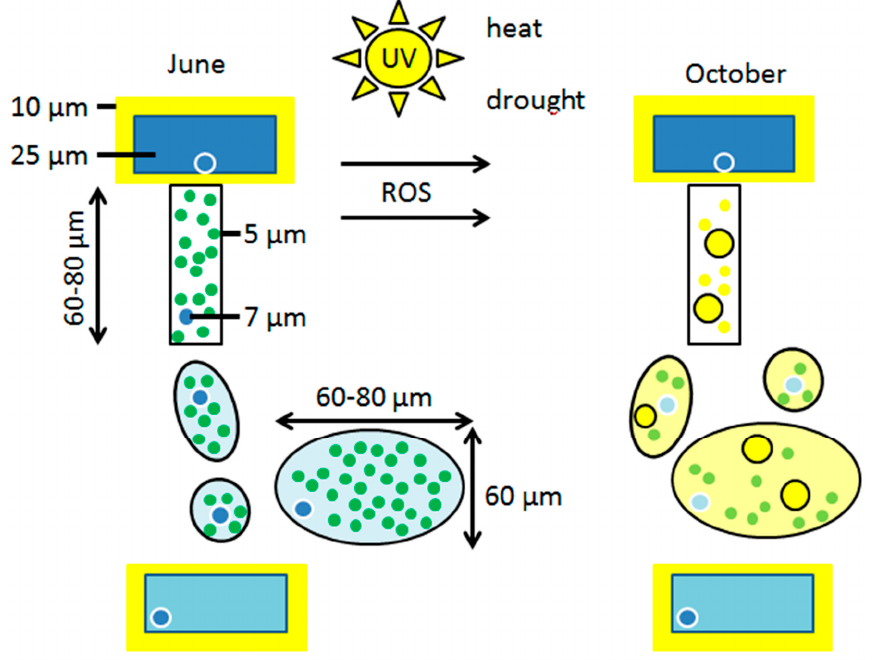
Figure 9. Schematic representation of the entire